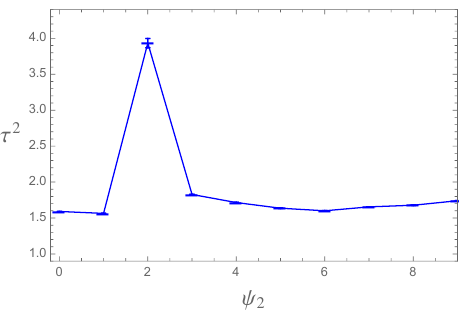
Figure 8 . The maximum Ricci scalar (left) and magnitude of the curvature squared invariant (right) on the points sampled for the quartic in P 3 given in (3.3), with 1 = 1 and 2 = 8, as a function of k . The Ricci scalar approaches zero exponentially as k is increased while the higher curvature invariant approaches a (cid:12)xed value.